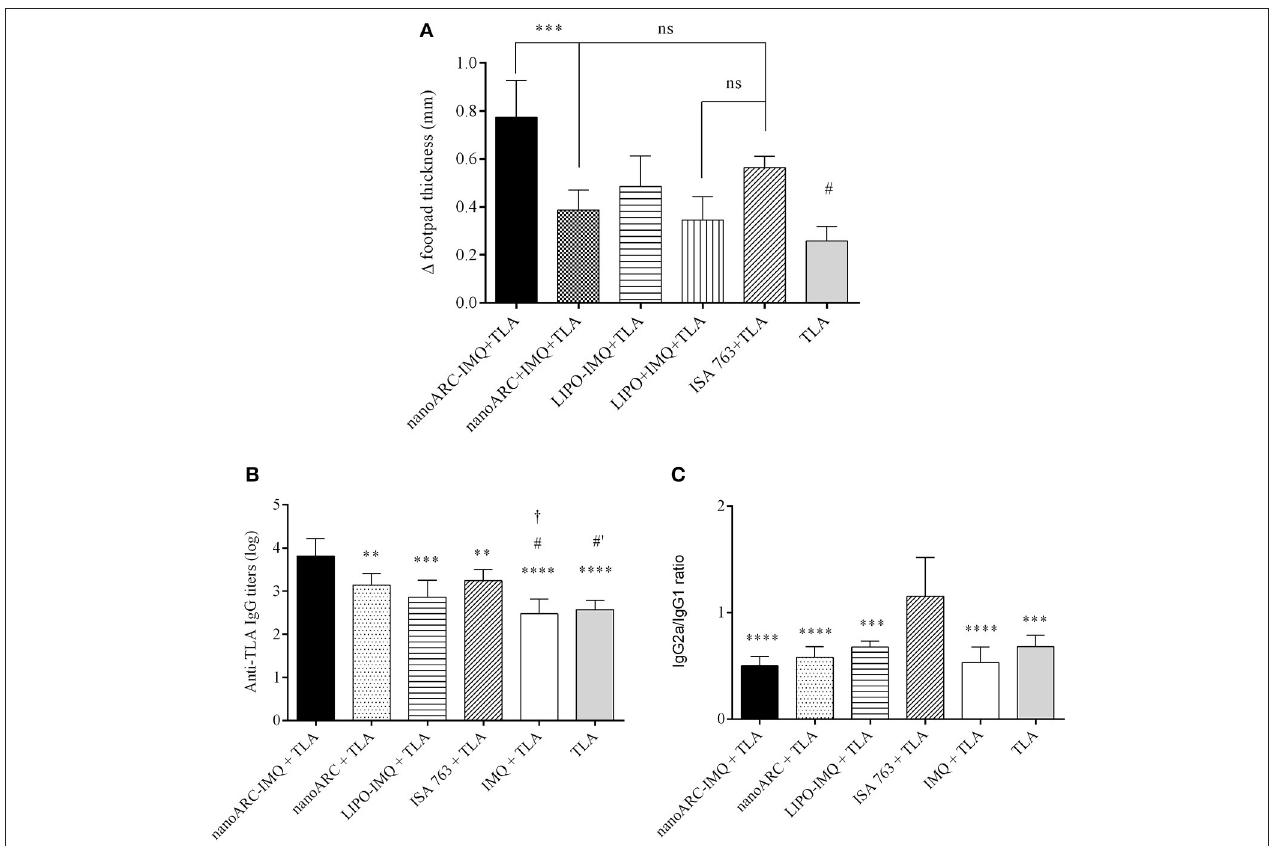
FIGURE 6 | (A) DTH. Asterisks represent statistical difference between nanoARC-IMQ + TLA and nanoARC + IMQ + TLA and numeral represents statistical difference between nanoARC-IMQ + TLA and IMQ + TLA (# p < 0.01). ns, no significant difference Values are expressed as mean ± SD ( n = 3), (B) Serum anti-TLA IgG titers at day 38 after 3 subcutaneous doses. Asterisks indicate significant differences between nanoARC-IMQ + TLA and remainder groups. Numerals indicate significate differences between ISA 763 + TLA and IMQ + TLA or TLA ( # p < 0.05; # ′ p < 0.01). The cross indicates significant differences between nanoARC + TLA † p < 0.05). Values are expressed as mean ± SD ( n = 3), (C) IgG2a/IgG1 isotype ratio at day 38. Asterisks indicate significant differences between and IMQ + TLA ( ISA 763 + TLA and the remainder groups. Values are expressed as mean ± SD ( n =